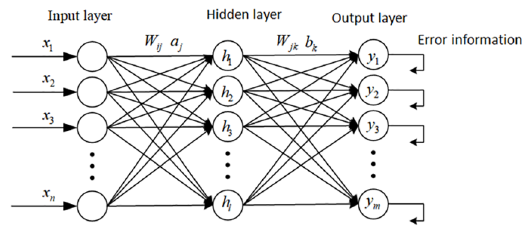
Figure 1. Schematic Diagram of BP Neural Network